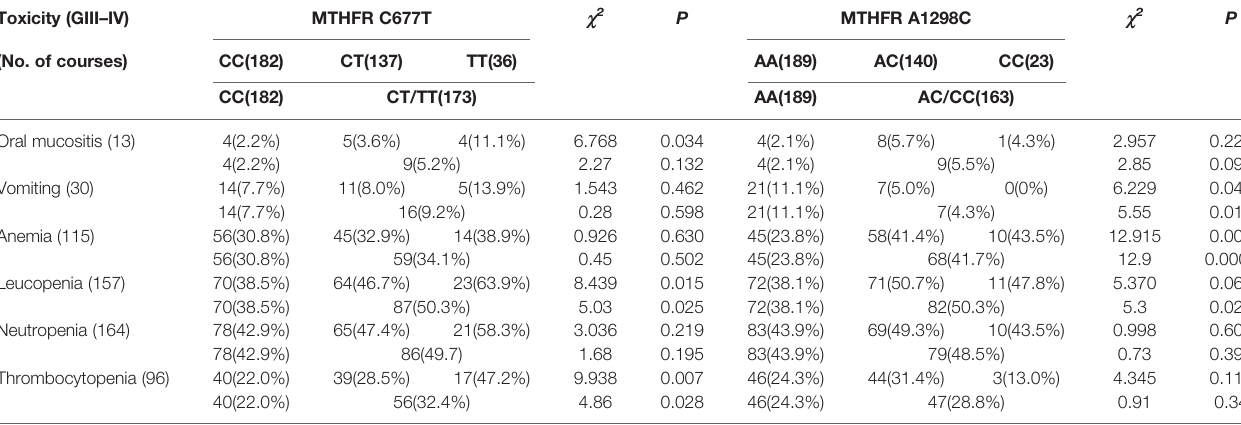
TABLE 5 | Associations between genetic polymorphisms and HD-MTX-related toxicities. Toxicity (GIII – IV) MTHFR C677T c 2 P MTHFR A1298C P (No. of courses)